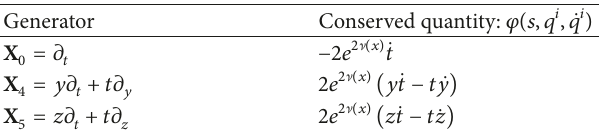
Table 33: Conserved quantities corresponding to each Noether symmetry.